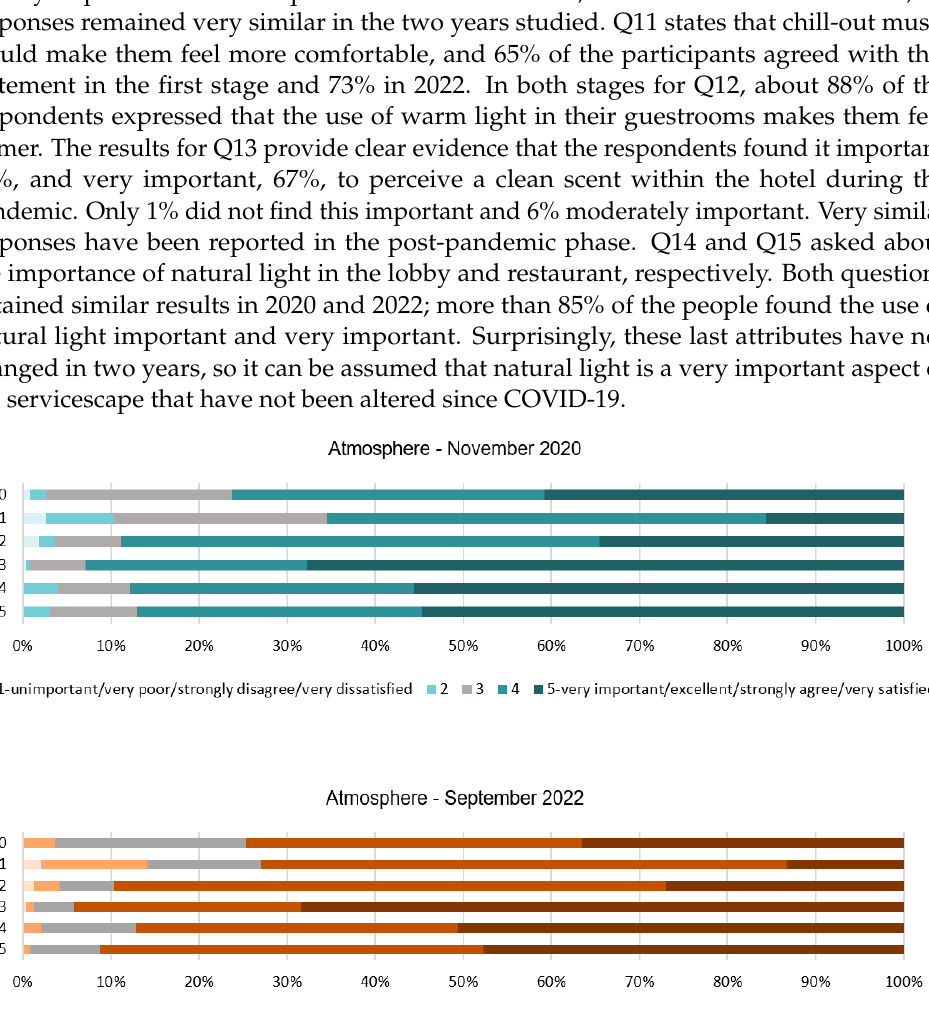
Figure 6. Atmosphere dimension chart.